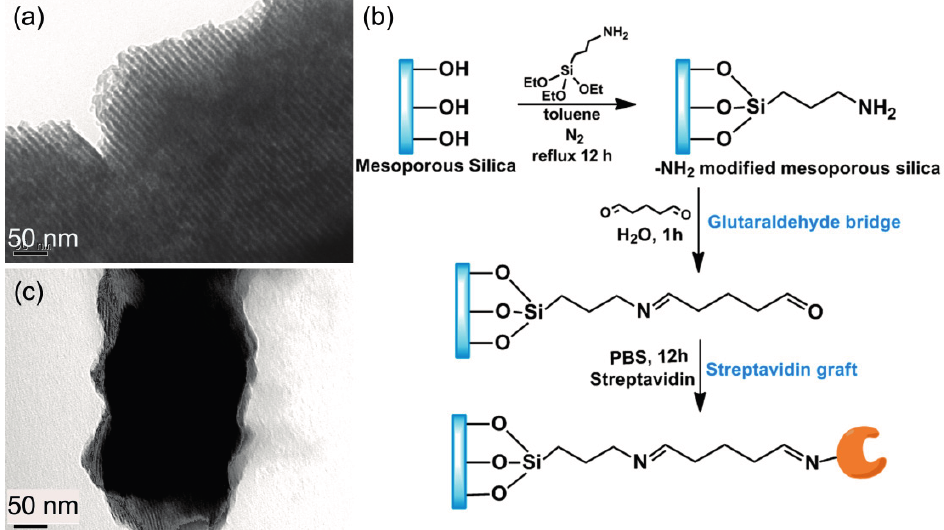
Figure 16. ( a ) TEM image showing ordered nano-structure of the mesoporous-silica raw material; ( b ) Schematic route of functionalizing streptavidin onto the mesoporous-silica; ( c ) TEM image of the streptavidin-functionalized mesoporous silica. Reprinted with permission from